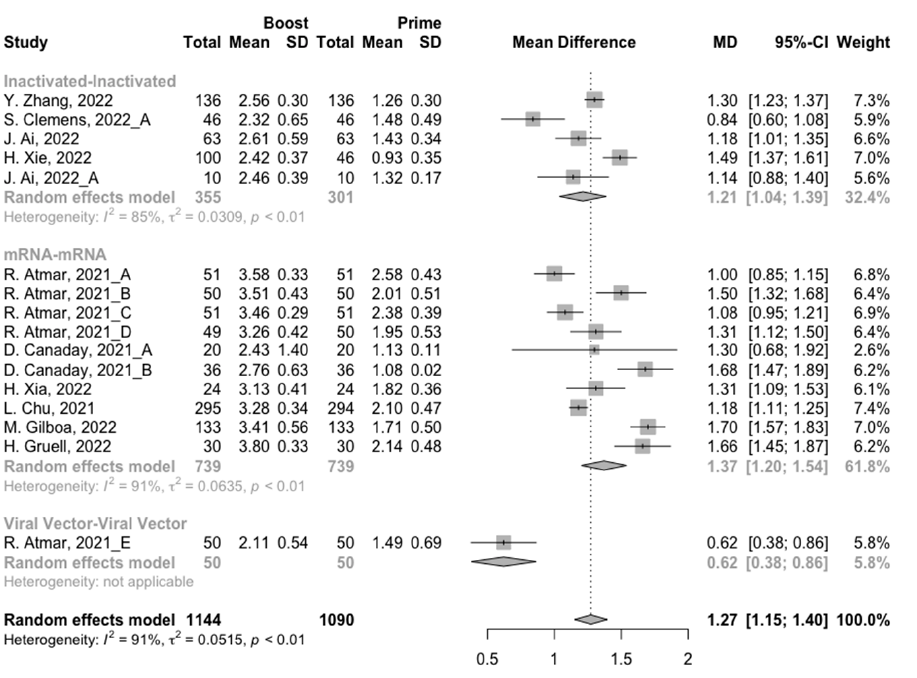
Figure 5. Forest plot of the pooled log-transformed neutralization antibody titers before and after homologous booster vaccination.